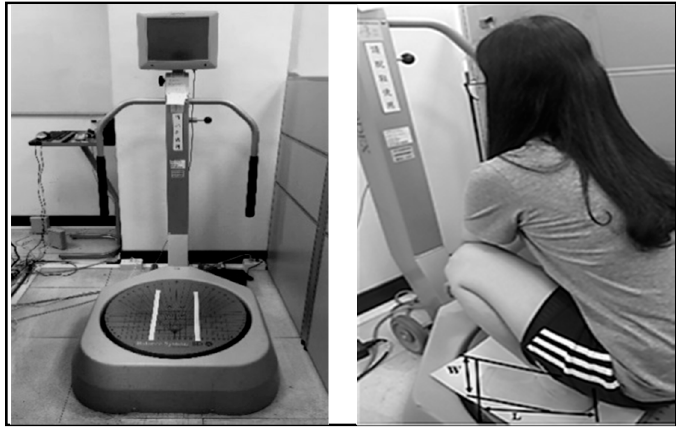
Figure 2. Measurement of squatting stability on the Biodex balance system